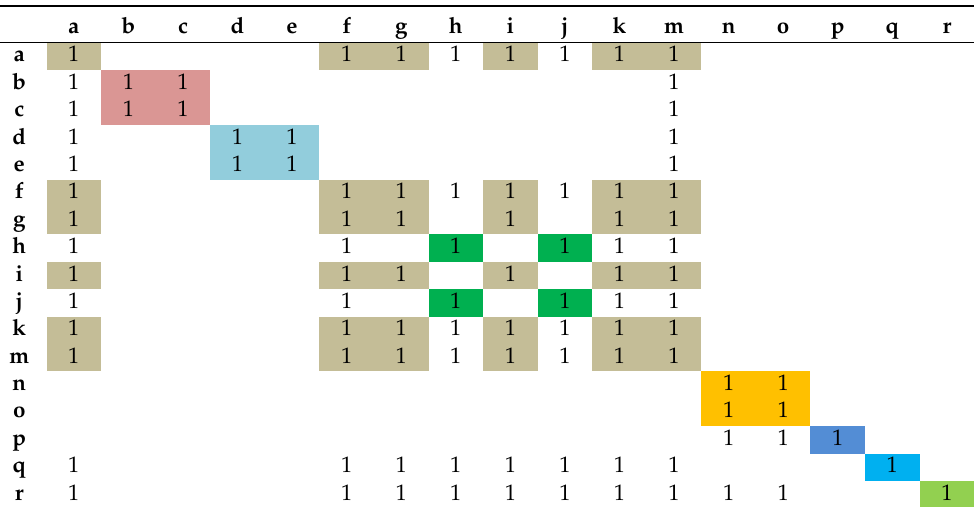
Table 5. Co-occurrence matrix for log L 2